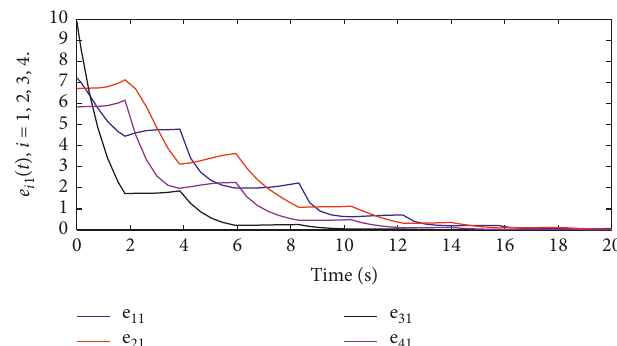
Figure 7: The state tracking error e